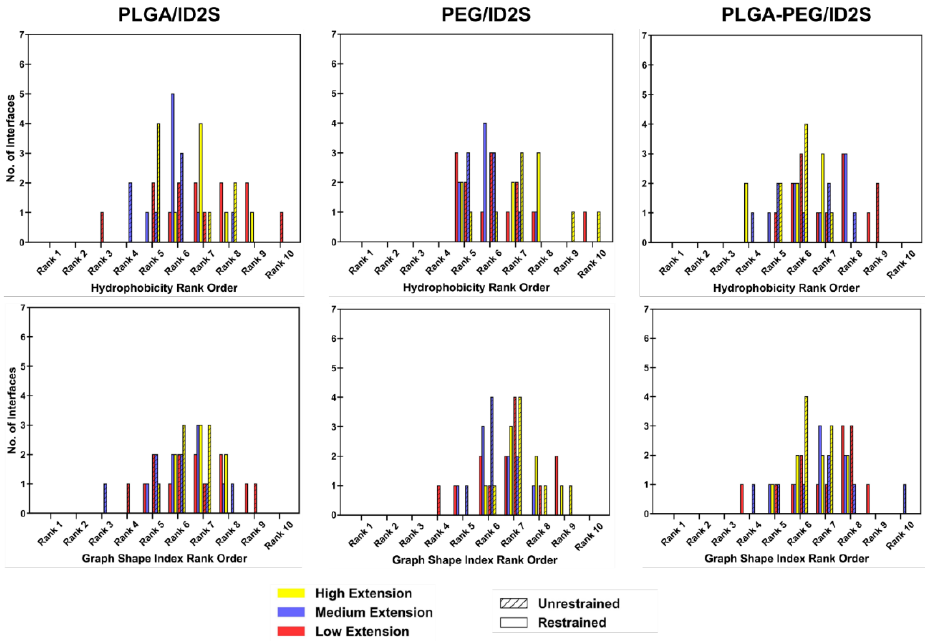
Figure A10. Hydrophobicity and graph shape index rank distributions of the collapsed filtered protein–polymer interface for PLGA/ID2S ( left column), PEG/ID2S ( middle column), and PLGA- PEG/ID2S ( right column) systems.